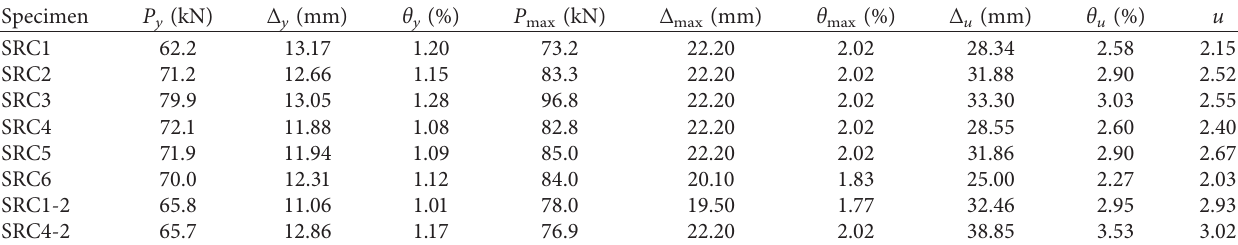
Table 3: Bearing capacity and deformation capacity of